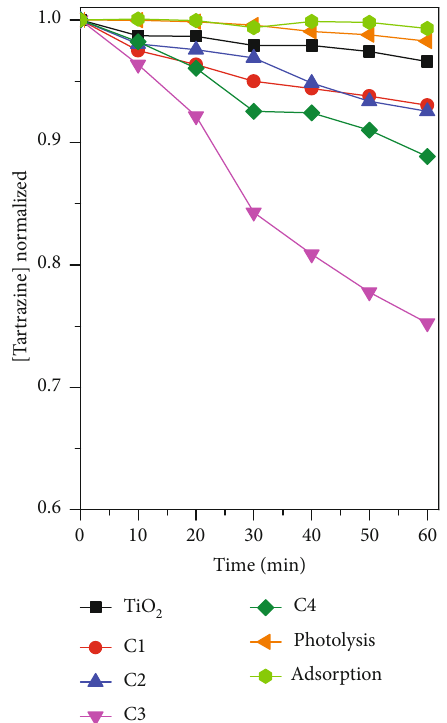
Figure 7: Tartrazine azo dye degradation curves in the presence of /GO. 2 UV lamp.